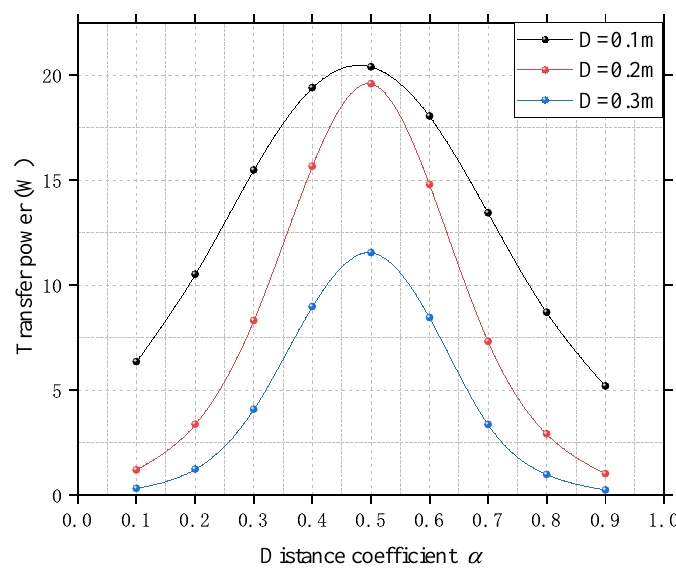
Figure 12. Experimental results of the MCR-WPT system with the intermediate coil-1.